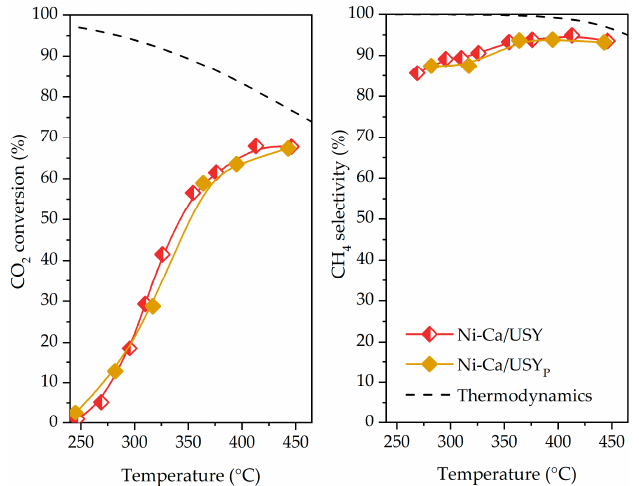
Figure 10. Catalytic performances obtained for Ni-Ca/USY and Ni-Ca/USY P catalysts after reduction at 470 °C. Operating conditions: 1 bar, 86 100 mL h − 1 g cat − 1 and CO 2 :H 2 :N 2 = 9:36:10.